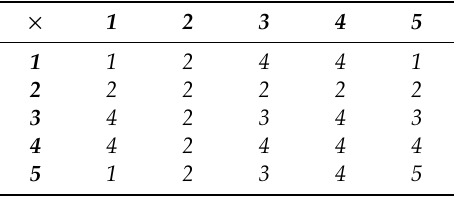
Table 10. The operation × on S